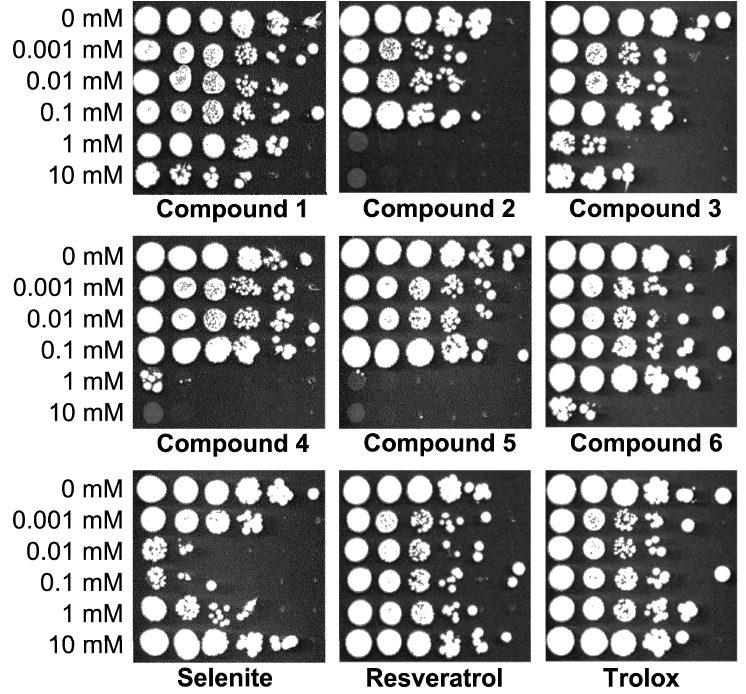
Figure 3. Toxicity of benzo[ b ]selenophenes in S. cerevisiae assessed by spot test. Horizontal lines are ten-fold serial dilutions of the yeast cell suspension. Representative experiment is shown.